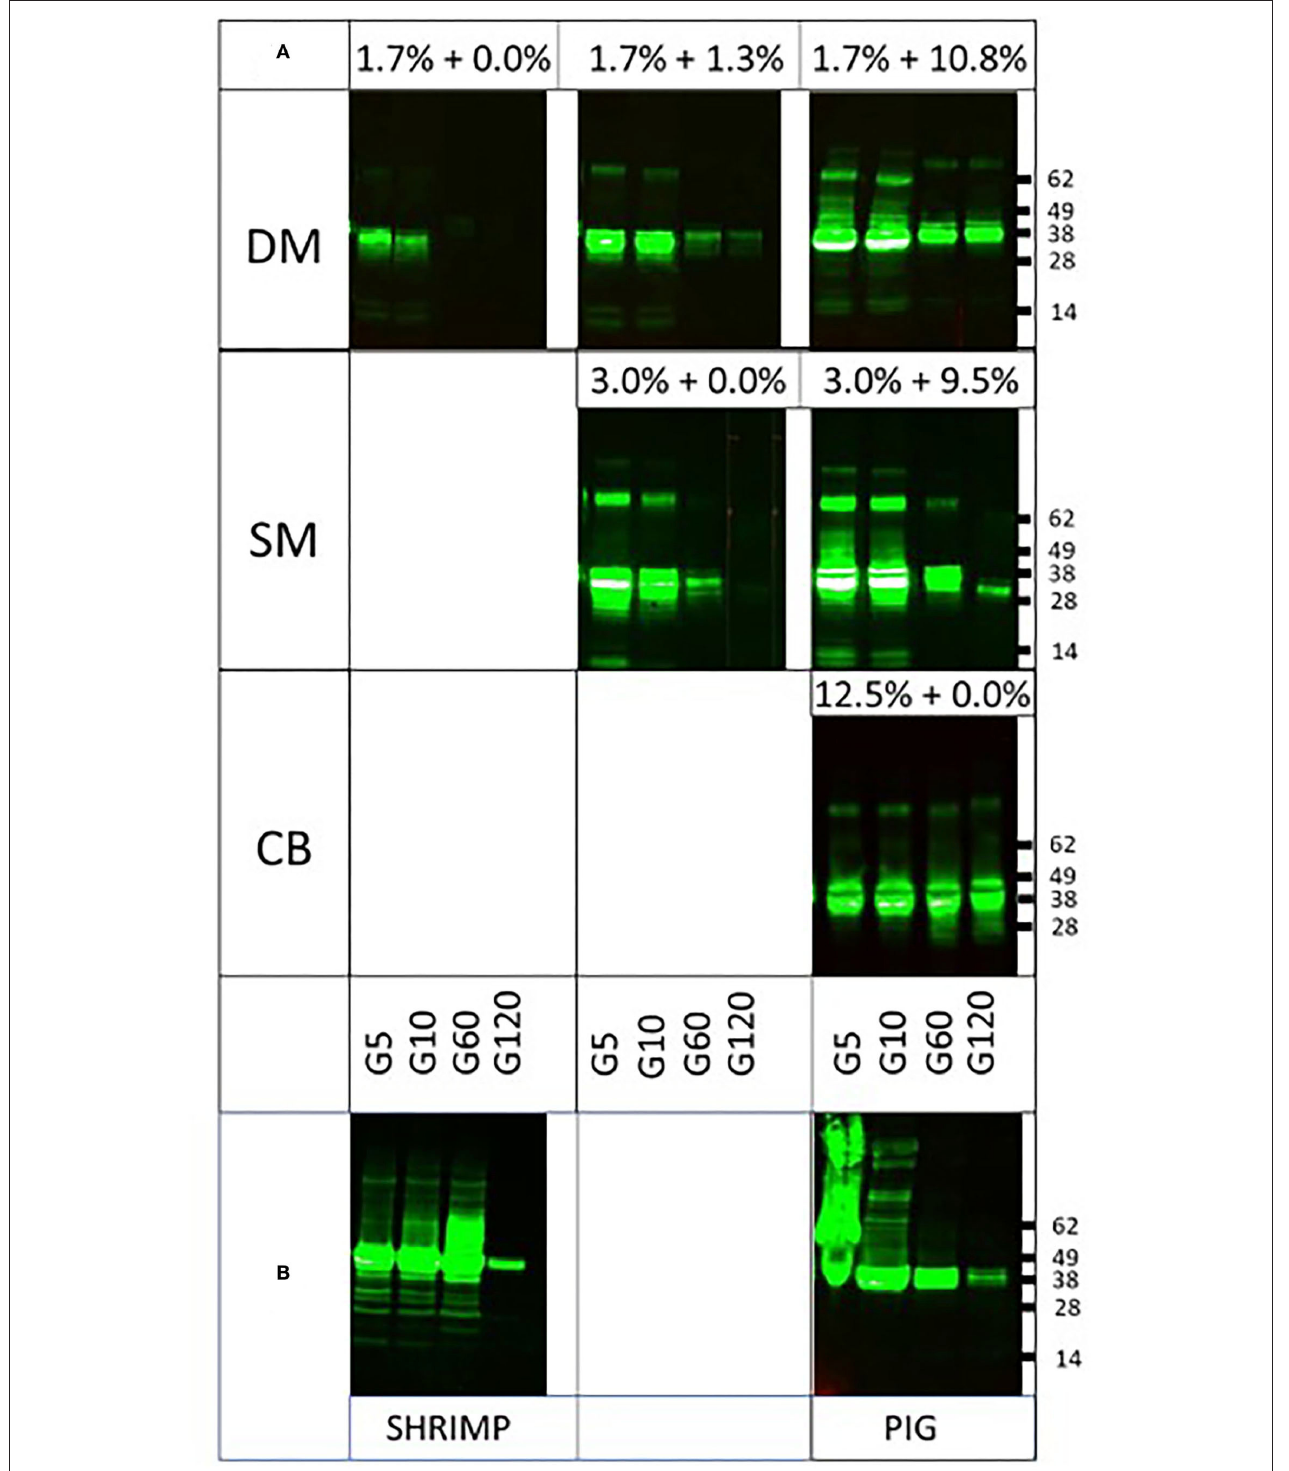
FIGURE 2 | Impact of extra protein from spiking or natural matrix on pepsin digestion of tropomyosins. DM, dessert mousse; SM, soy milk; CB, chocolate bar. Samples were taken at 5 (G5), 10 (G10), 60 (G60), and 120 (G120) min of pepsin digestion. Samples were analyzed by immunoblot with respective tropomyosin-specific antibodies. Molecular weight markers are indicated on the side in kDa. (A) Impact on pepsin digestion of tropomyosins of the addition of BSA to DM to the percentage of protein found in SM and CB, respectively, and of addition of BSA to SM to the percentage of protein found in CB. (B) Impact on pepsin digestion of tropomyosins by their respective endogenous protein-rich